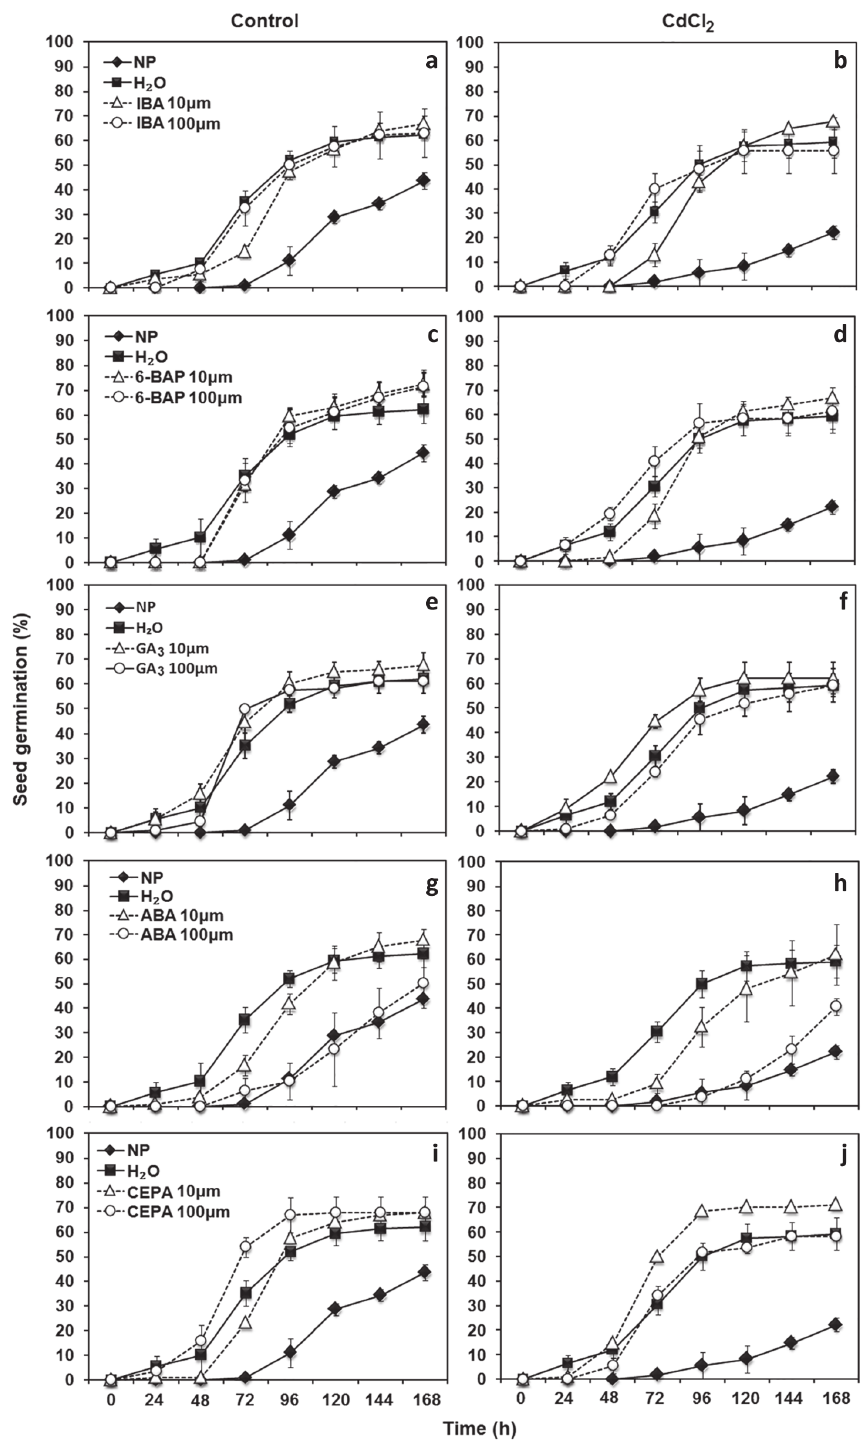
Figure 1 - Seed germination percentage at 24h intervals (G with hormones (a-b) auxin (IBA), (c-d) cytokinin (6-BAP), (e-f) gibberellins (GA), (g-h) abscisic acid (ABA) and (i-j) ethylene (CEPA) incubated in control condition or under cadmium stress (CdCl ) during 168h. Error bars represent 2